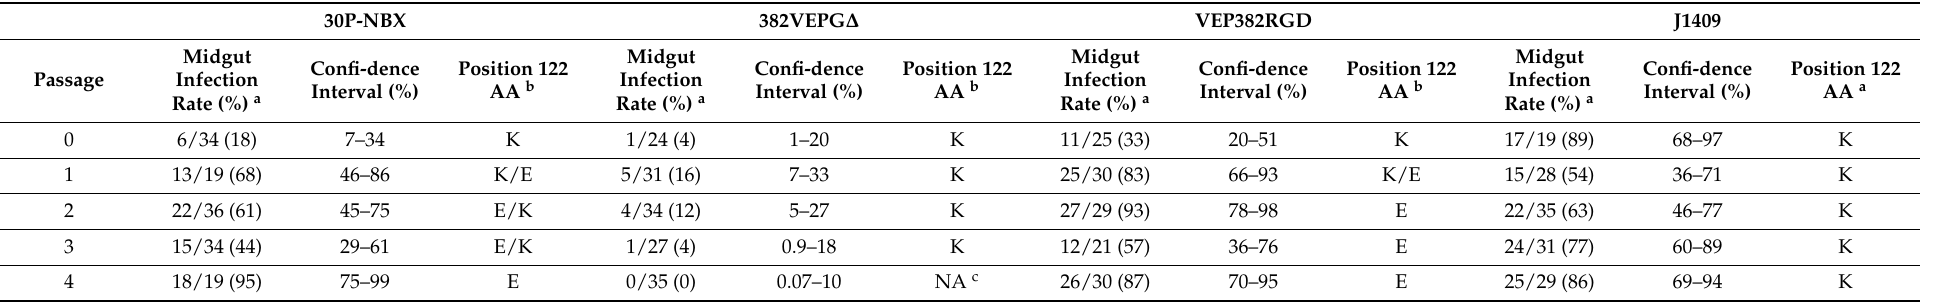
Table 1. Midgut infection rates and genetic changes after serial passage of 30P-NBX, 382VEPG ∆ , VEP382RGD, and J1409 in Ae. aegypti RexD